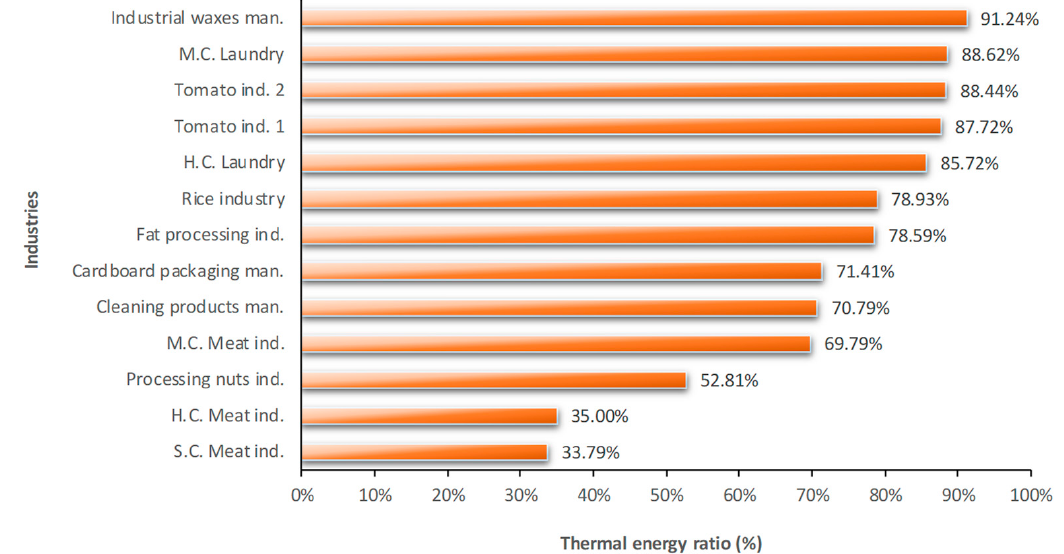
Figure 3. Classification according to thermal energy ratio.